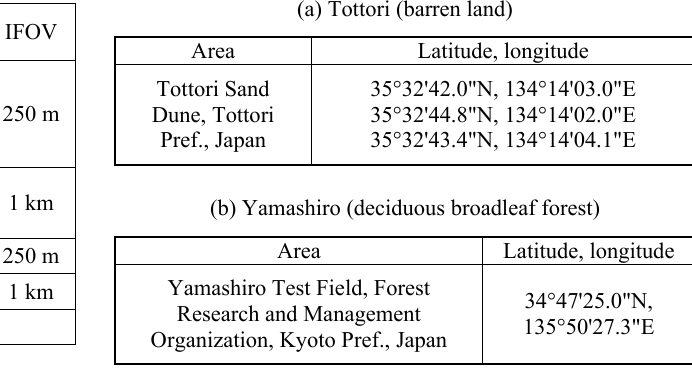
Table 1. Specifications of Second-generation Global Imager (SGLI) channels (GCOMa, 2021). Table 2. Names and geolocations of study